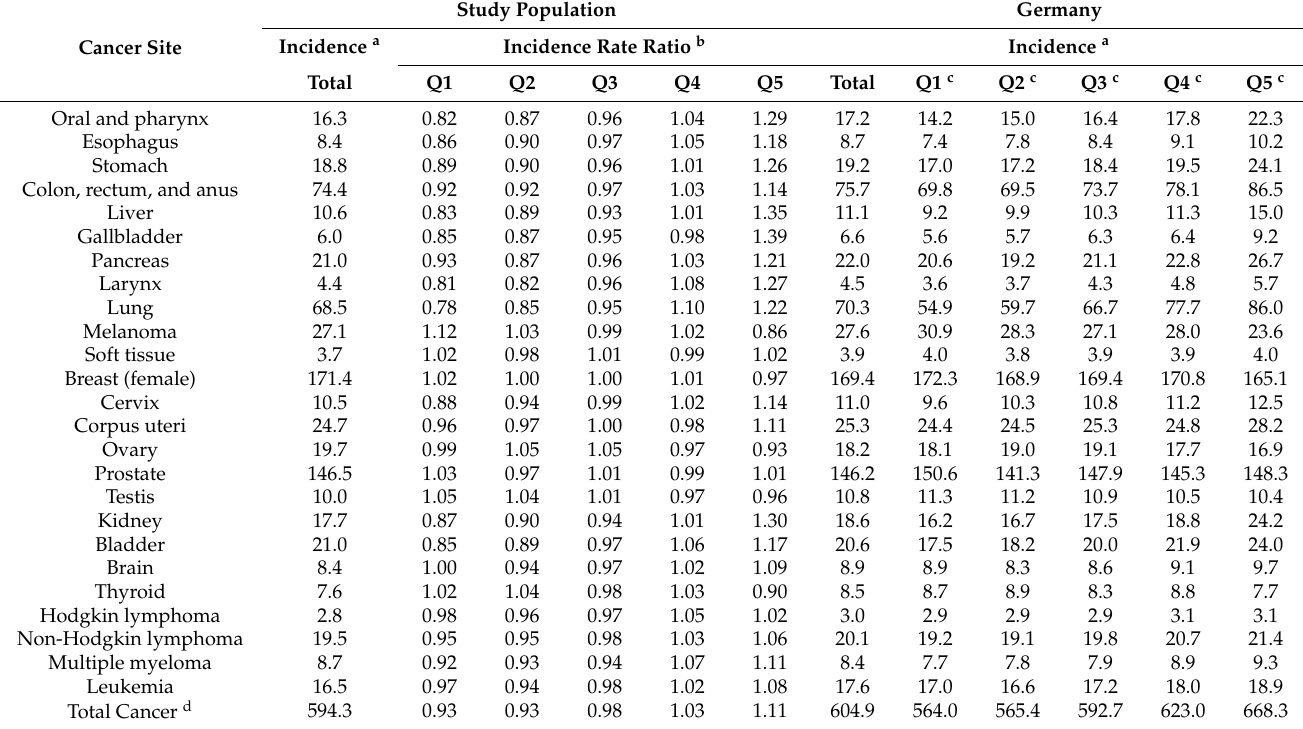
Table 4. Cancer incidence rates and rate ratios in the study population (2013–2017) for each deprivation quintile on a municipality level compared to the overall incidence in the study population (left side) and overall cancer incidence rate and estimated incidence rates in each deprivation quintile in Germany